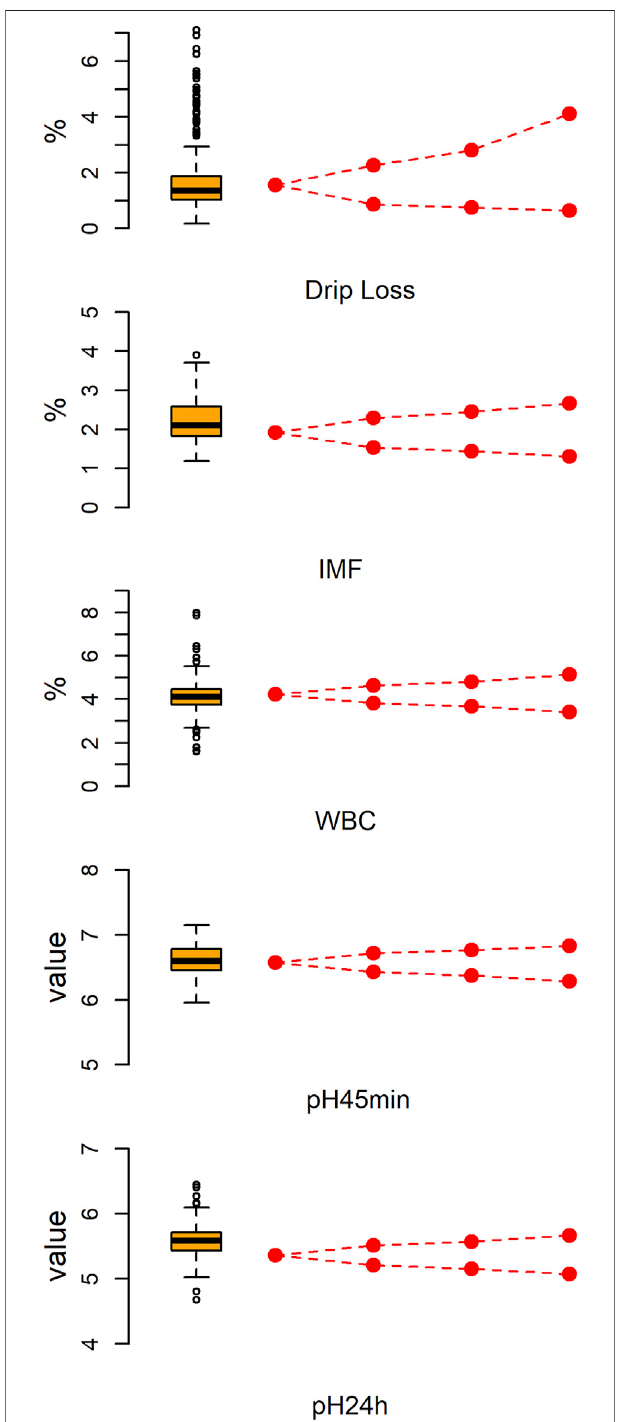
FIGURE1| Thephenotypicdistributionof fi ve meatquality traits and the tendency of phenotypic values in phenotypic gradient differential population pairs. The left is a box-whiskers plot. The right line graph displays a gradual change tendency of phenotypic mean value from the source population to fi rst through third population